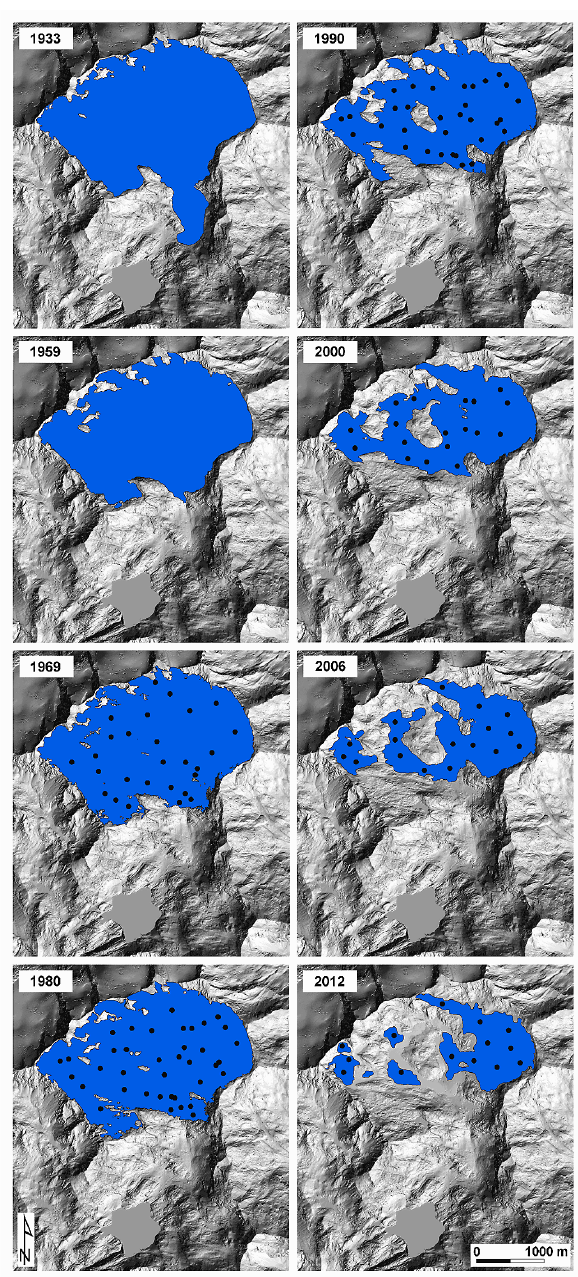
Fig. 6. Extent of the Careser Glacier in eight different epochs from 1933 to 2012. The black dots represent the location of ablation